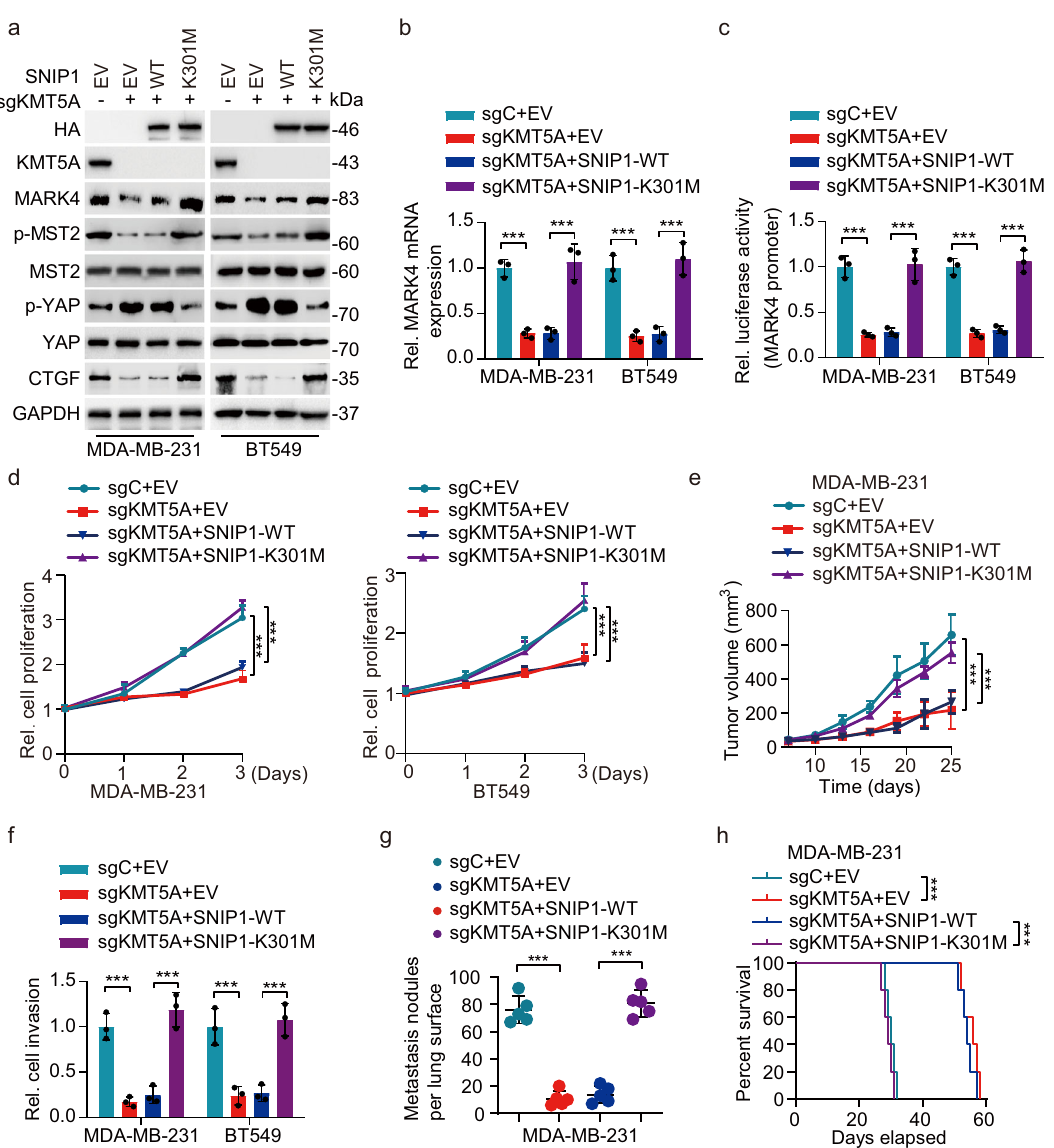
Fig. 4 KMT5A-mediated SNIP1 K301 methylation promotes TNBC metastasis via activating YAP signaling. a Western blotting for ectopic expression of SNIP1 WT or SNIP1 K301M mutant combined with KMT5A knockout on MARK4 protein expression and Hippo signaling activation in MDA-MB-231